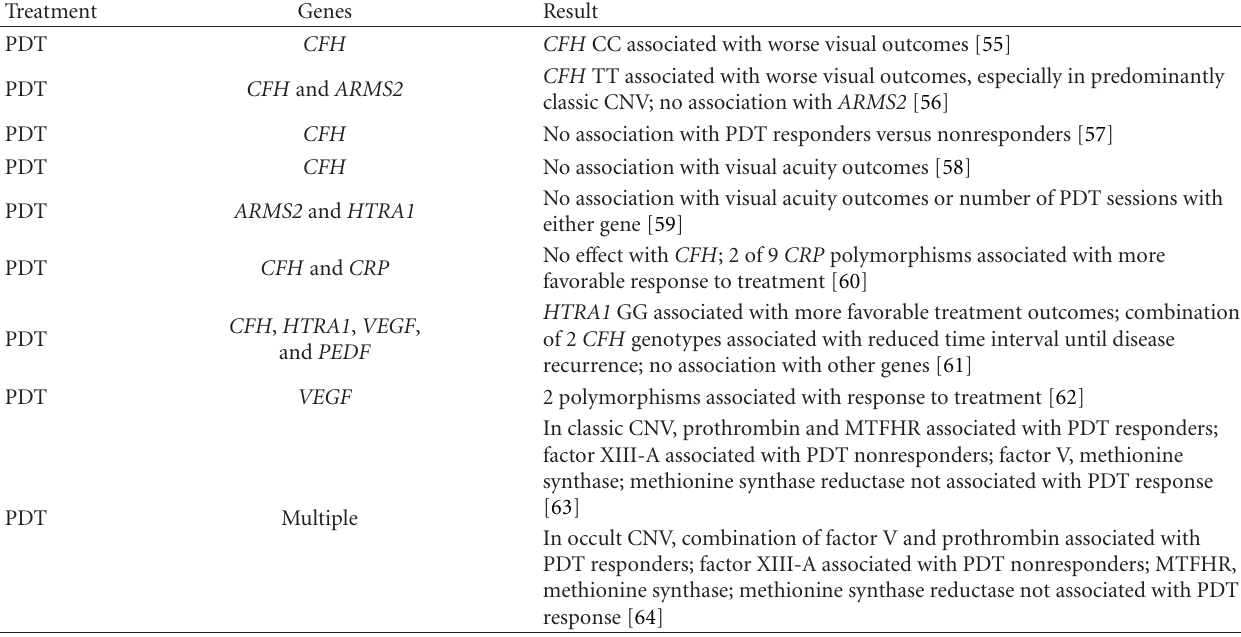
Table 2: Pharmacogenetics of photodynamic